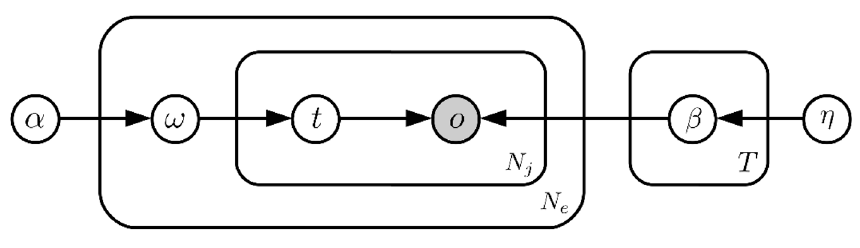
Figure 3 . The graphical model of smoothed